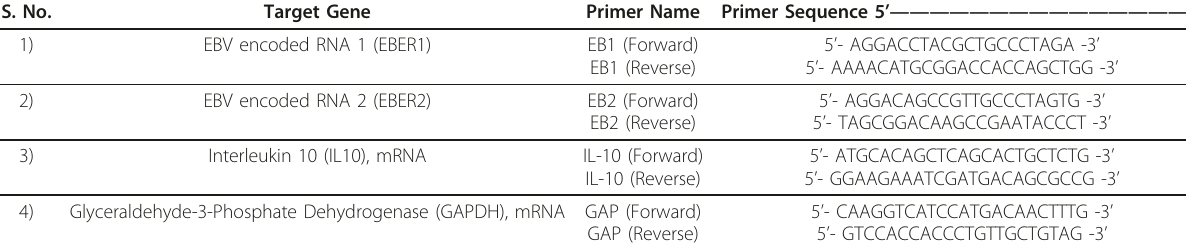
Table 1 Specification of Primers used in RT-PCR and qRT-PCR Experiments S.